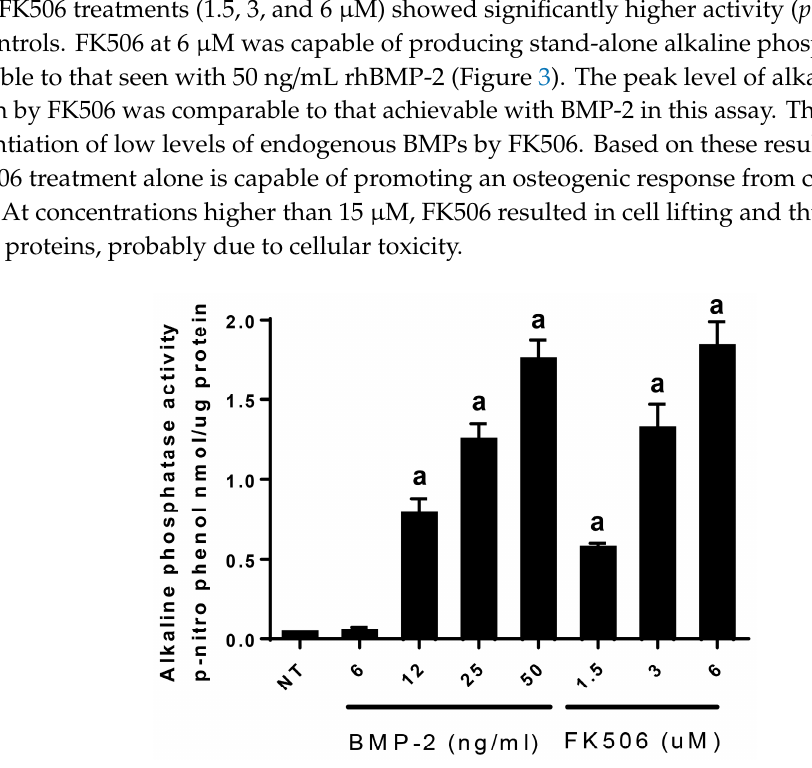
Figure 3. FK506 independently mimics BMP-2 induction of alkaline phosphatase activity. FK506 (6 µ M) was capable of producing a stand-alone alkaline phosphatase induction comparable to that seen with 50 ng / mL rhBMP-2 in a 3 day experiment. The peak level of alkaline phosphatase induction was comparable to that achievable with BMP-2 in this assay. Data points were determined in triplicate. Statistical significance from the BMP-2 control group ( p < 0.05) was obtained as detailed in “Materials and Methods”, and is denoted by a.